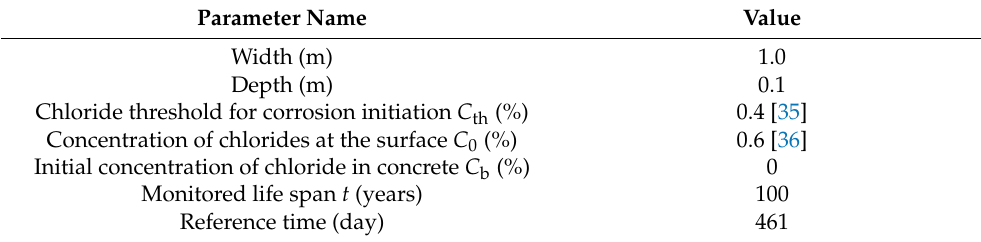
Table 5. Input parameters of numerical